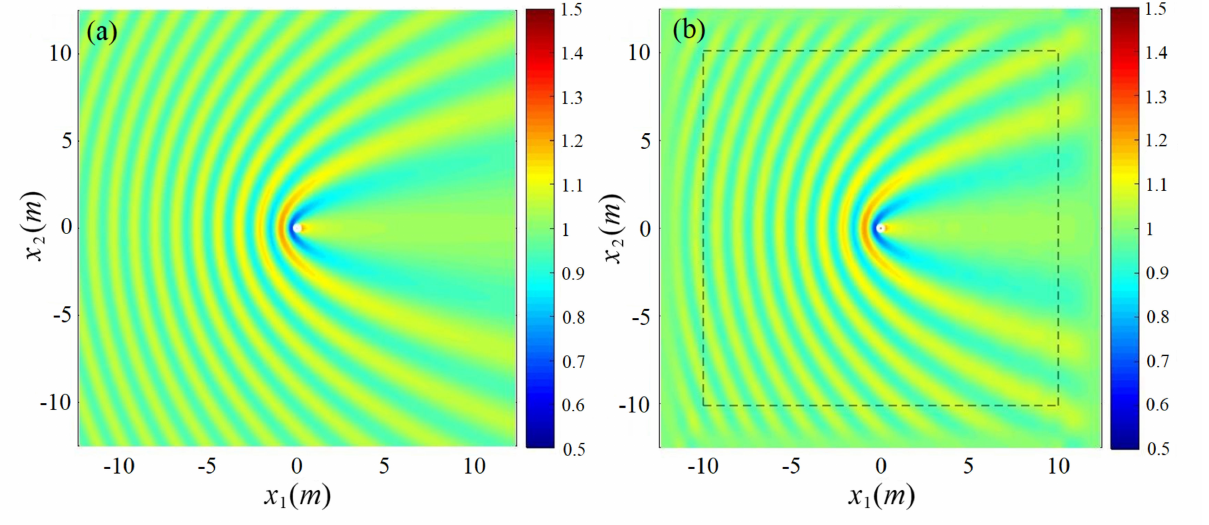
Figure 4. Wave height distribution on the plane around a circular inclusion of R W = 0.1575 m for incident waves of unit height and period T = 1.26 s, in water depth h = 0.8 m, for α = 2 , β = 0.05 , ( a ) Analytical solution. ( b ) Results for the same case as obtained by the present FDM numerical solution using N = 501 × 501 mesh and the PML region indicated by using a dashed